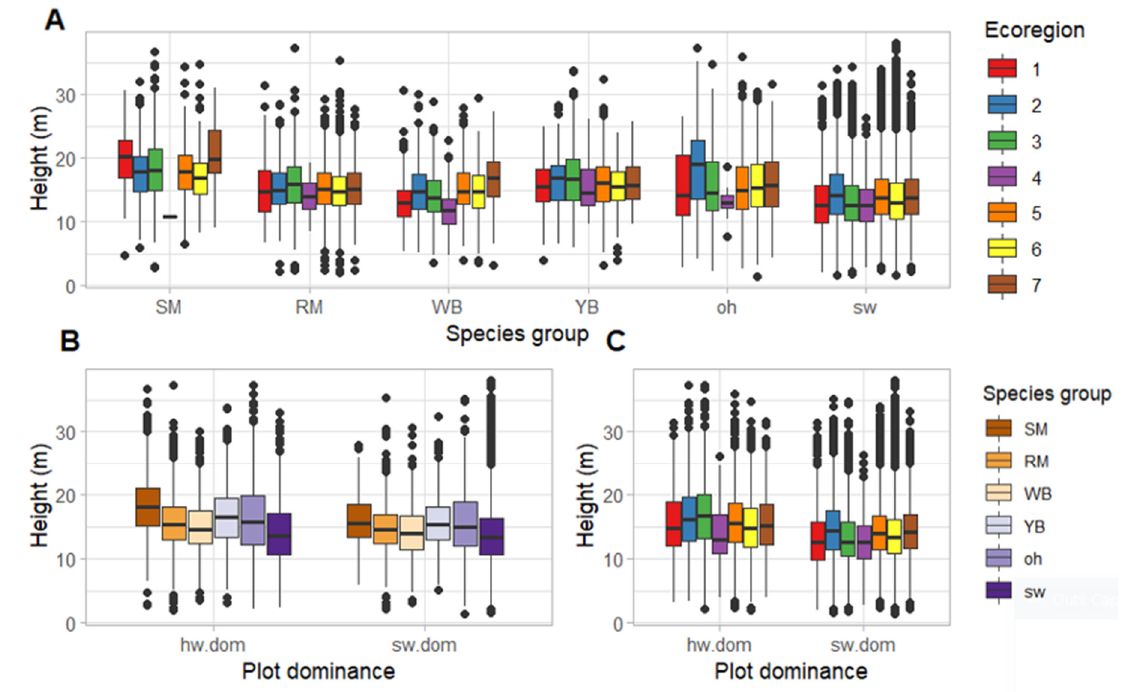
Figure 10. Tree height (N = 62,292) depending on species (SM: sugar maple; RM: red maple; WB: white birch; YB: yellow birch; oh: other hardwoods; sw: softwoods) and ecoregion (1 to 7) ( A ), plot dominance (hardwood dominated (“hw.dom”) or softwood dominated (“sw.dom”)) and grouped species ( B ) and plot dominance and ecoregion ( C ).